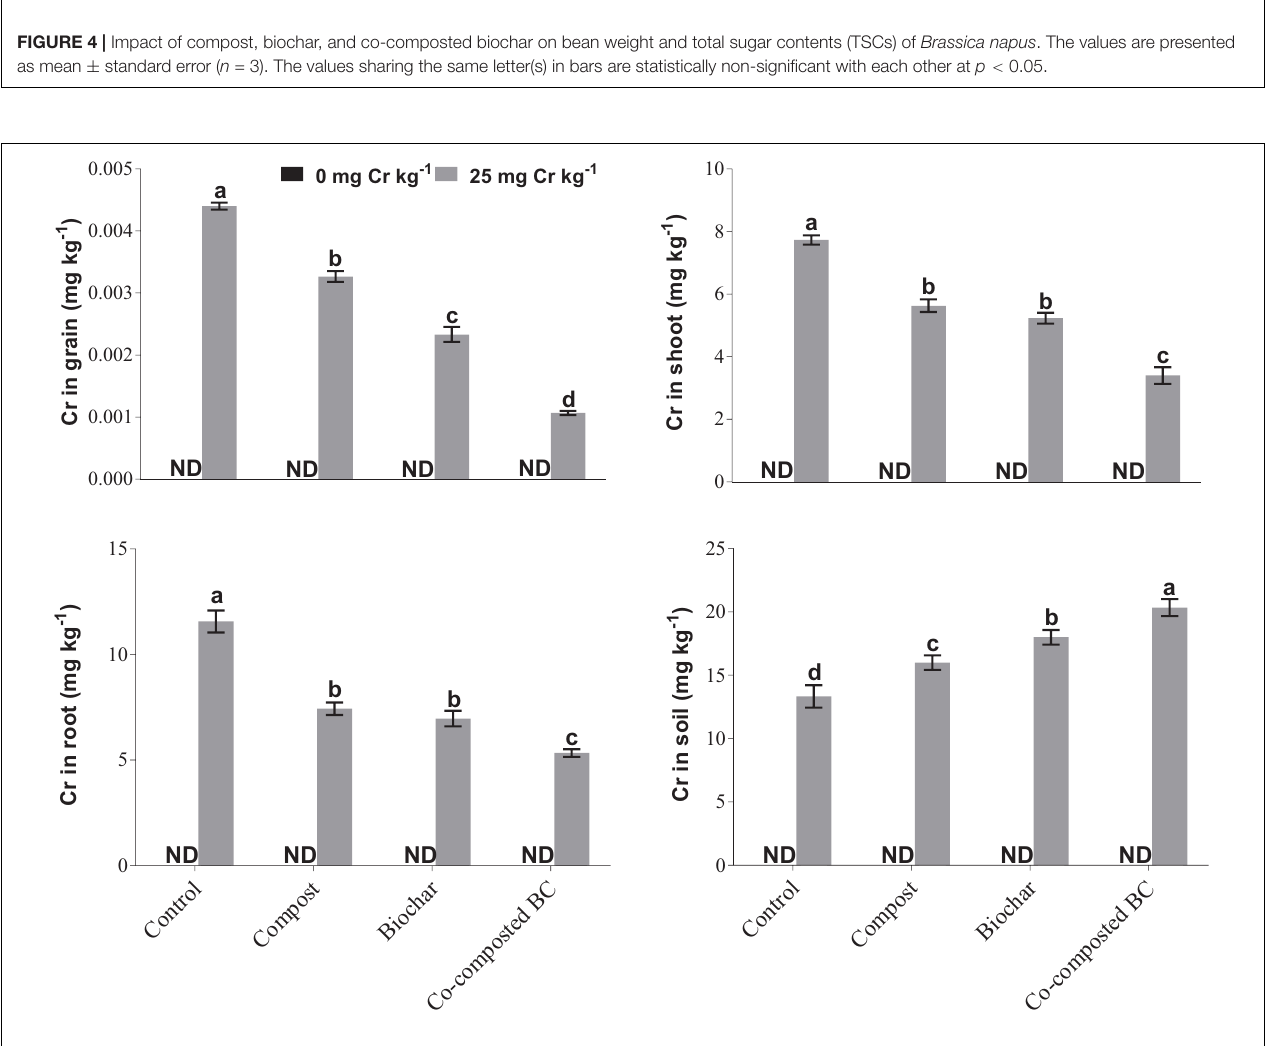
FIGURE 5 | Impact of compost, biochar, and co-composted biochar on Cr accumulation in different portions of Brassica napus . The values are presented as mean ± standard error ( n = 3). The values sharing the same letter(s) in bars are statistically non-significant with each other at p < 0.05.